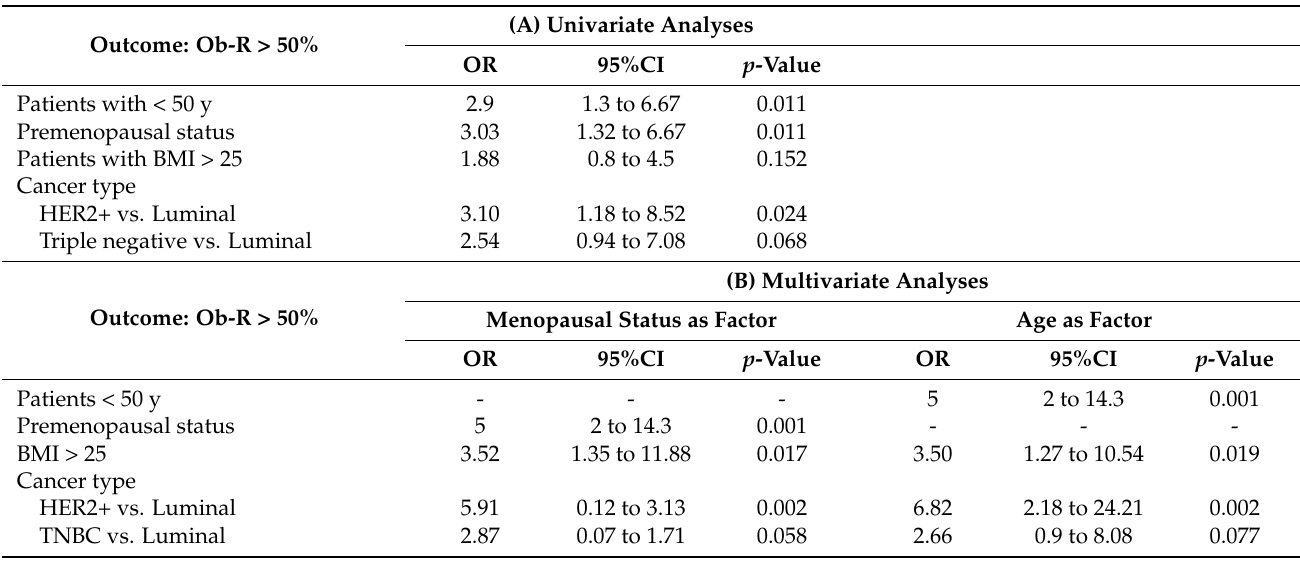
Table 2. Ob-R cell overexpression (>50%) in accordance with baseline characteristics: univariate and multivariate logistic regression model analyses. ( A )Univariate analyses;( B )Multivariate